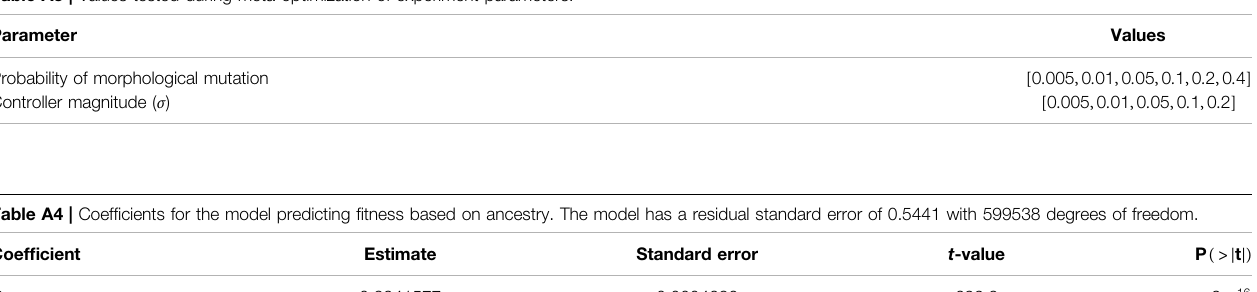
Table A3 | Values tested during meta-optimization of experiment parameters.